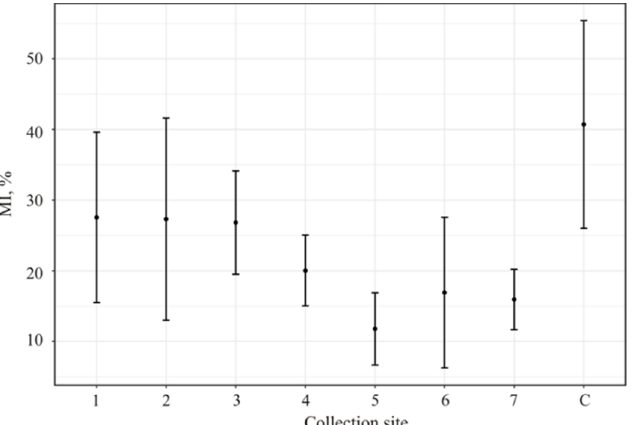
Figure 2. A. cepa root meristem cell MIs after soaking in the water from investigated water bodies. 1. The Reindeer Creek plant; 2. The Tul’yok River; 3. The Teply Creek; 4. The Komarinoe Lake; 5. The Vuonnemyok River; 6. The Umbolka River; 7. Bolshoy Vudjavr Lake; C-control (distiller water); MIs (%) -mitotic index.